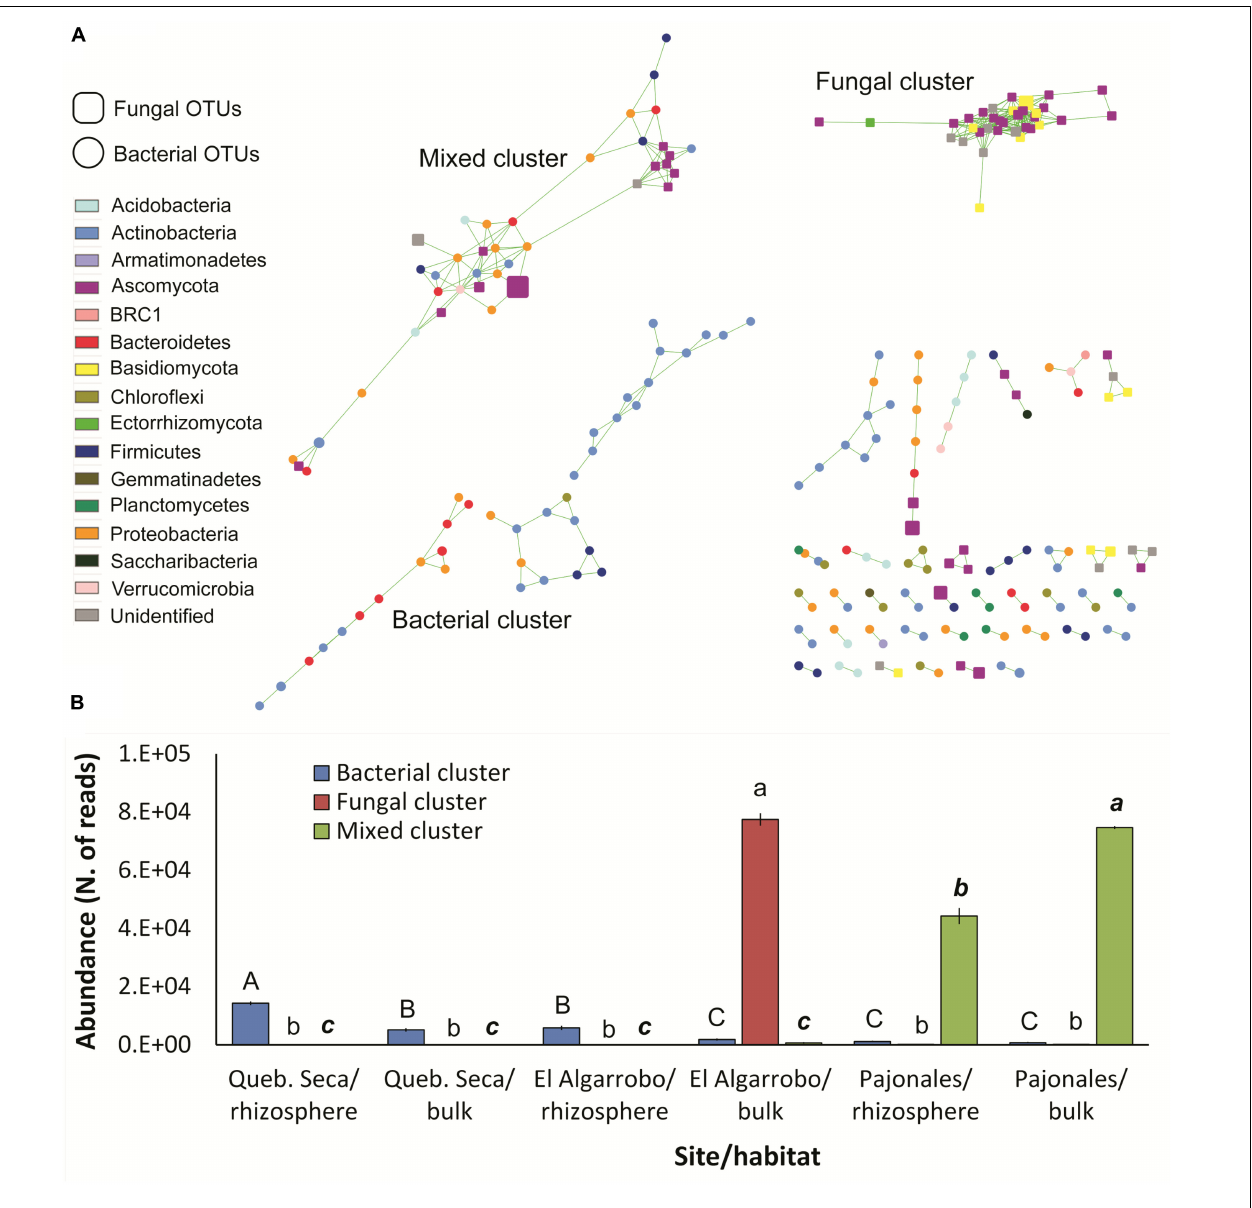
FIGURE 4 | Network analysis of the bacterial-fungal microbiome associated to C. longiscapa during the Atacama flowering desert event. (A) Bacterial and fungal OTUs (round and squared nodes, respectively) are correlated to each other if connected by a green line. Node size indicates the respective mean OTU abundance. Node color indicates the taxonomic affiliation. The three main clusters detected are labeled. (B) Distribution of the three clusters across the three sites and the two habitats (rhizosphere/bulk). Different letters indicates significantly different means for each cluster (Tukey test, p <